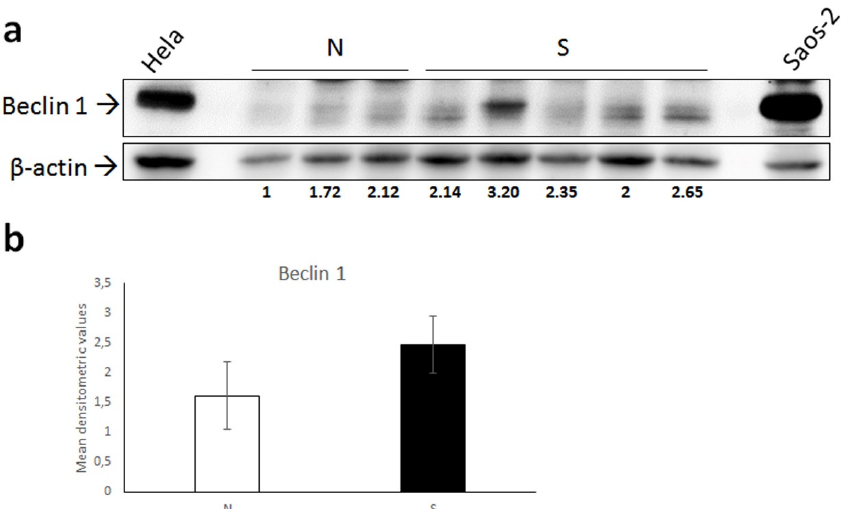
Figure 3. ( a ) Western blot analysis for Beclin 1 in normal skin samples (N) and equine sarcoids (S). Cell lysates from Hela and Saos-2 cell lines were run on the gel to demonstrate the specificity of the antibody. Following stripping of the membrane, anti β -actin antibody was applied in order to allow normalization. Densitometric ratio Beclin 1/ β -actin for each normal and sarcoid sample is indicated. ( b ) Mean densitometric values +/ − standard deviation of N vs. S group (original Western blot figure is in Figure S1).